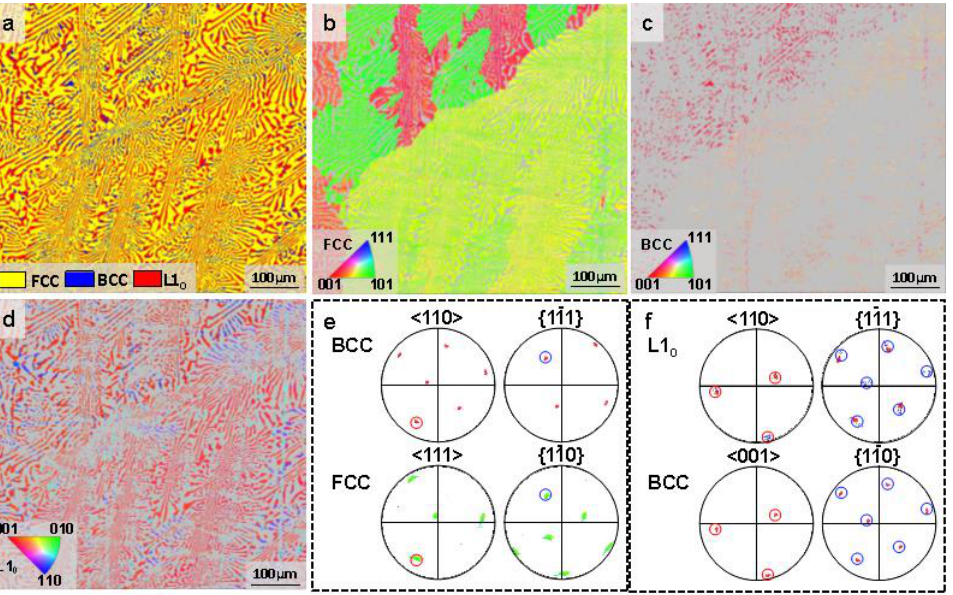
Figure 9. EBSD results for the 0 T sample. ( a ) Phase map; ( b ) IPF map of FCC phases; ( c ) IPF map of BCC phases; ( d ) IPF map of L1 0 phases; ( e ) pole figures of FCC and BCC phases in a single eutectic colony. The pole points on the (1-11) (blue circle) and [110] (red circle) pole figures of the BCC phase overlap with those on the (1-10) (blue circle) and [111] (red circle) pole figures of the FCC phase; ( f ) pole figures of L1 0 martensite and BCC austenite. The pole points on the (1-11) (blue circle) and [110] (red circle) pole figures of the L1 0 phase overlap with those on the (1-10) (blue circle) and [001] (red circle) pole figures of the BCC austenite phase, implying the preferred orientation relationship.